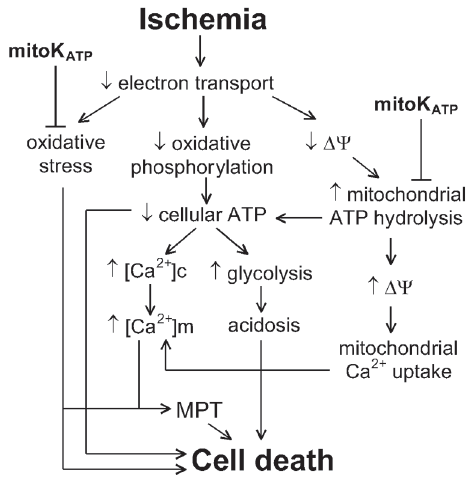
Figure 2. Proposed cardioprotective effects of